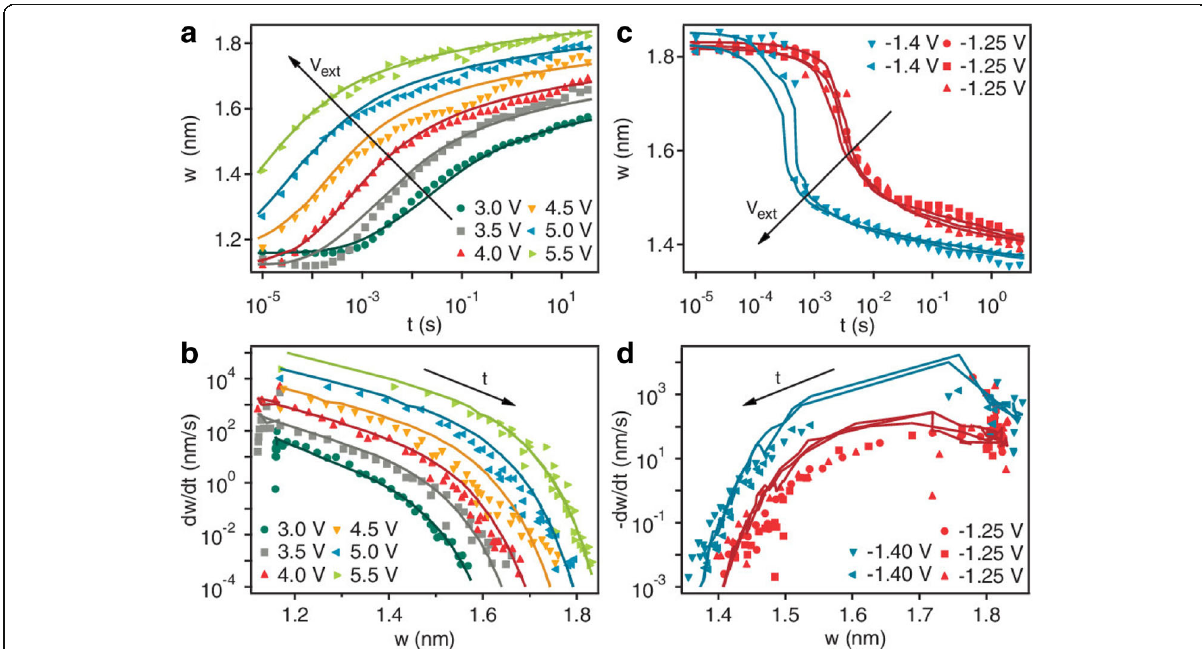
Fig. 6 Dynamical behavior of the tunnel barrier width w . The evolution of the state variable w occurs as a function of time for different applied voltages for a series of a off-switching and c on-switching state tests on the same device. Legends indicate the applied external voltage. The lines are the numerical solution to the respective switching differential equations described in the text. b , d The numerical derivative w ˙ of the data in a and c plotted as a function of w for the different applied voltages. The lines are calculated from the differential equations using the measured values of w and i at each point in time. The irregularity of the calculated w ˙ vs w lines in the on-switching plots is caused by the changes in the current that accompany the change in state ( w ˙ is a function of two variables, w and i , and both are changing). The derivative of the state variable w ˙ can be inter- preted as the speed of the oxygen vacancy front. This is because the applied voltage pushes it away from or attracts it toward the top electrode